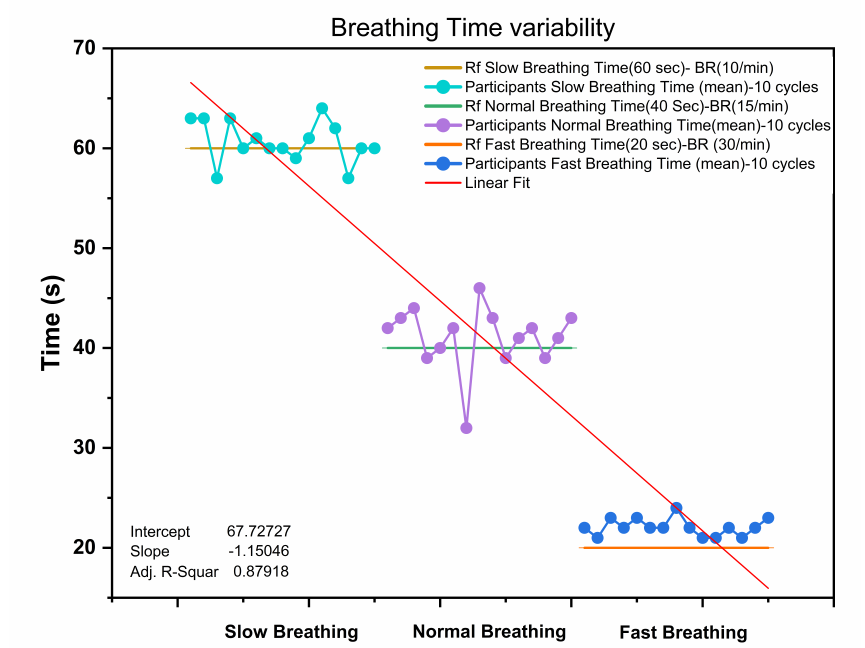
Figure 18. Breathing − time variability of 15 participants during the breathing test (slow, normal, and